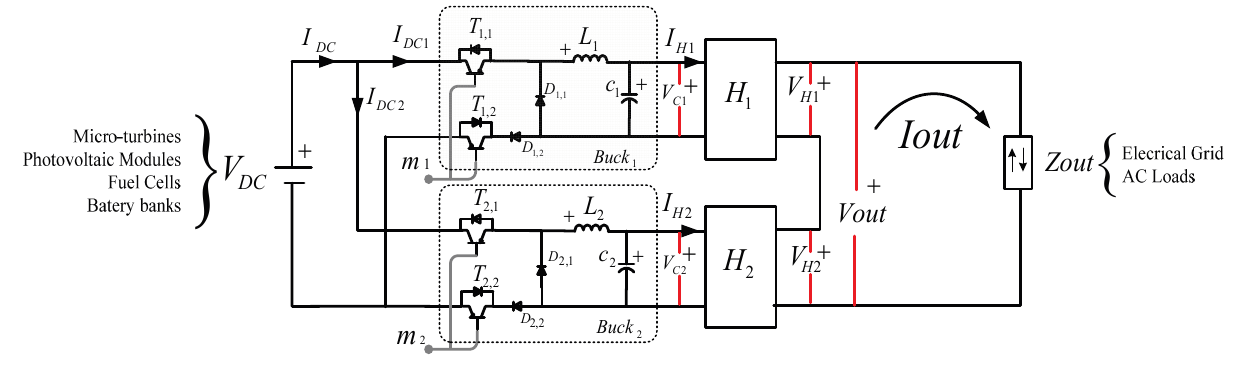
Figure 1. Single DC nine-level DC/AC hybrid proposed